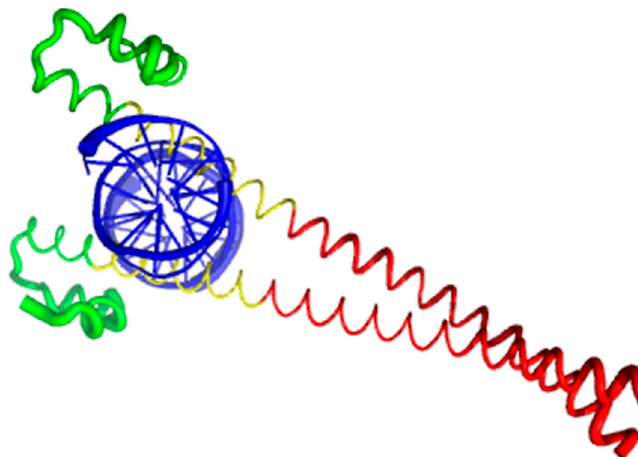
Figure 4. Crystal structure of the complex between the musculoaponeurotic fibrosarcoma (MAF) bZIP transcription factor A (MAFA) and MAF recognition element (MARE) (PDB entry 4EOT), where the flexibility of different protein regions is shown by varying the thickness of the backbone (based on the B-factor values). Here, more flexible regions are shown by thicker backbone. As can be expected, the loop areas that point toward the aqueous environment are the most flexible regions of this domain in its bound form. The extended homology region (EHR), the basic region, and the leucine zipper domain are shown by green, yellow, and red color, respectively. DNA molecule is shown by blue color. The EHR of MAFA is mobile, as reflected by high B factors.